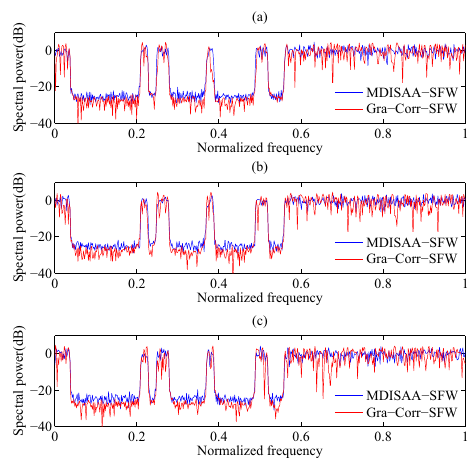
Figure 8. The spectral power of the waveform sets designed by MDISAA-SFW and